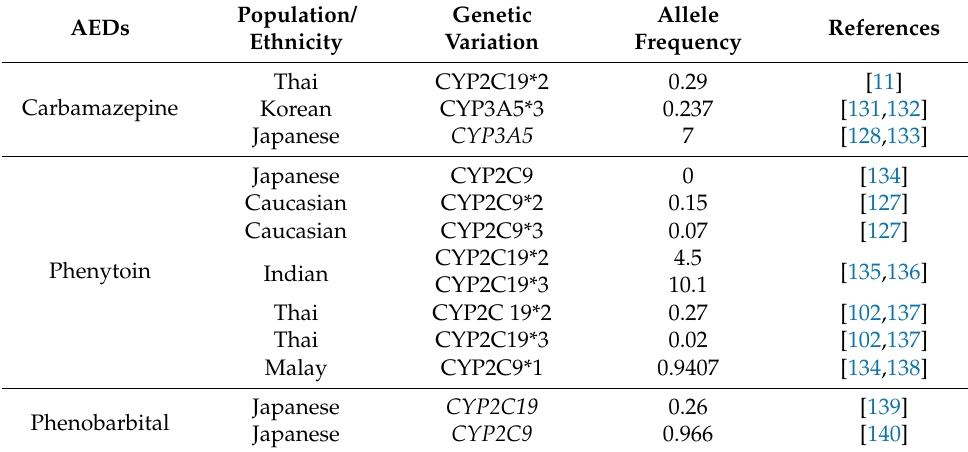
Table 3. Cytochrome P450 allele frequency for various